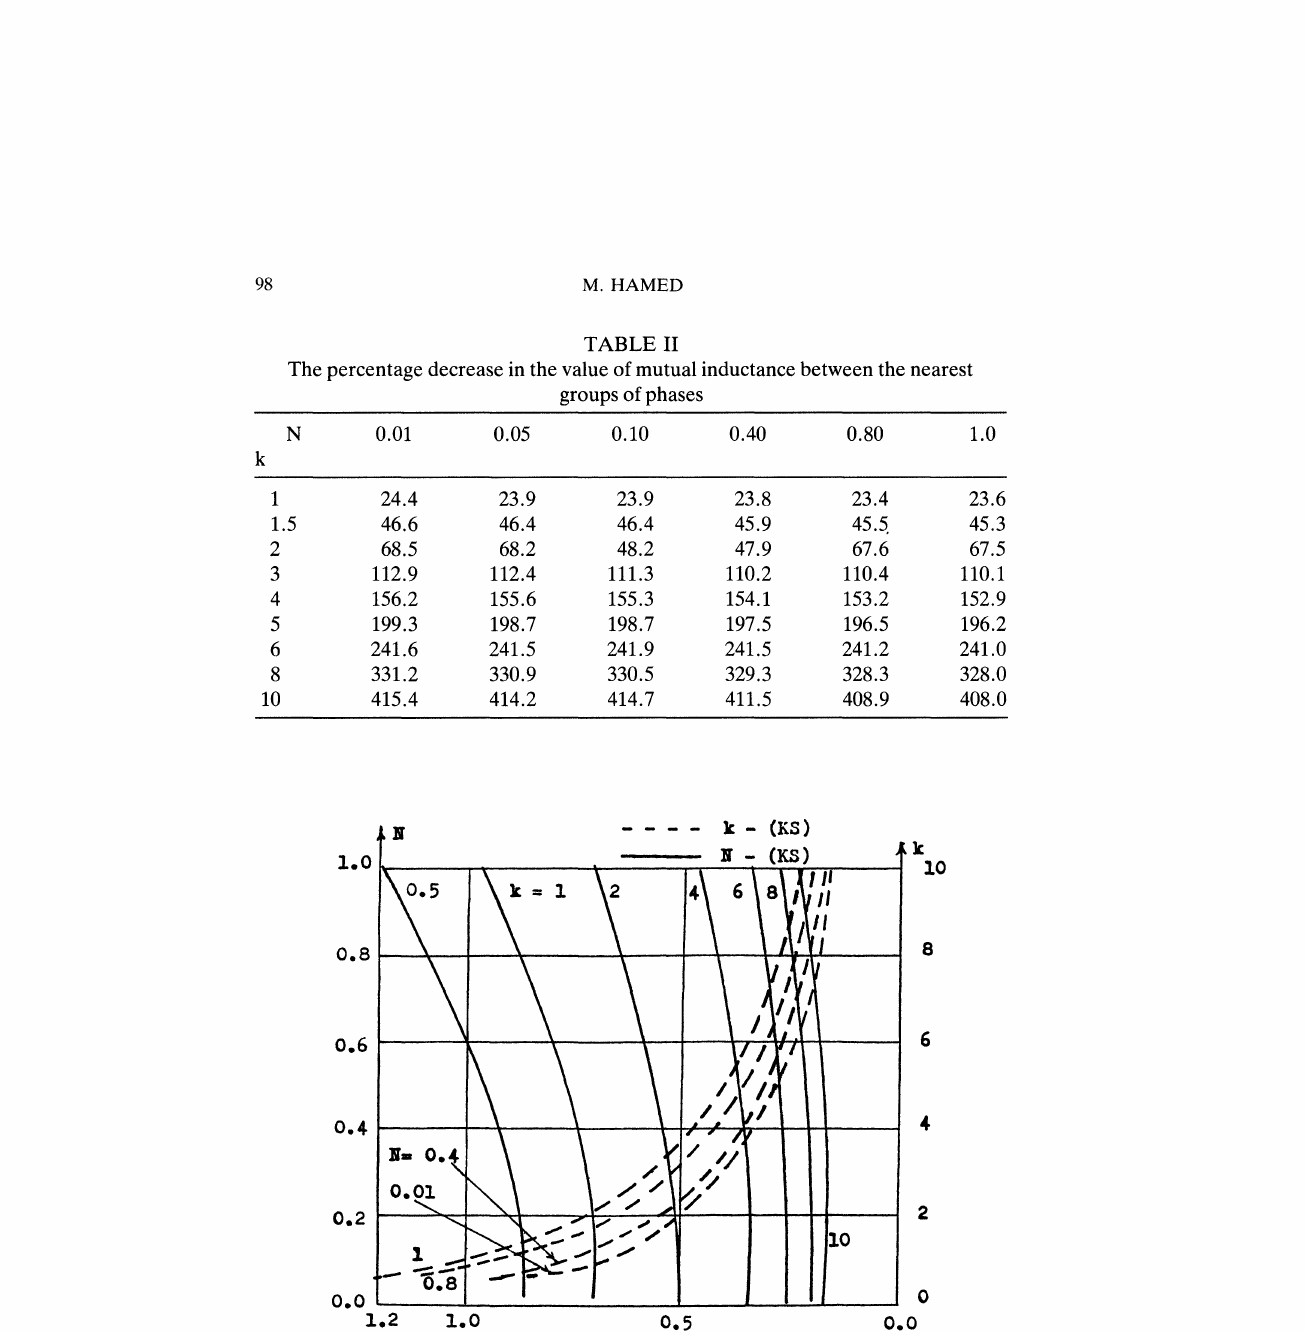
FIGURE 8 The dependency of coefficient KS on factors k and N at a constant angle Q of 90